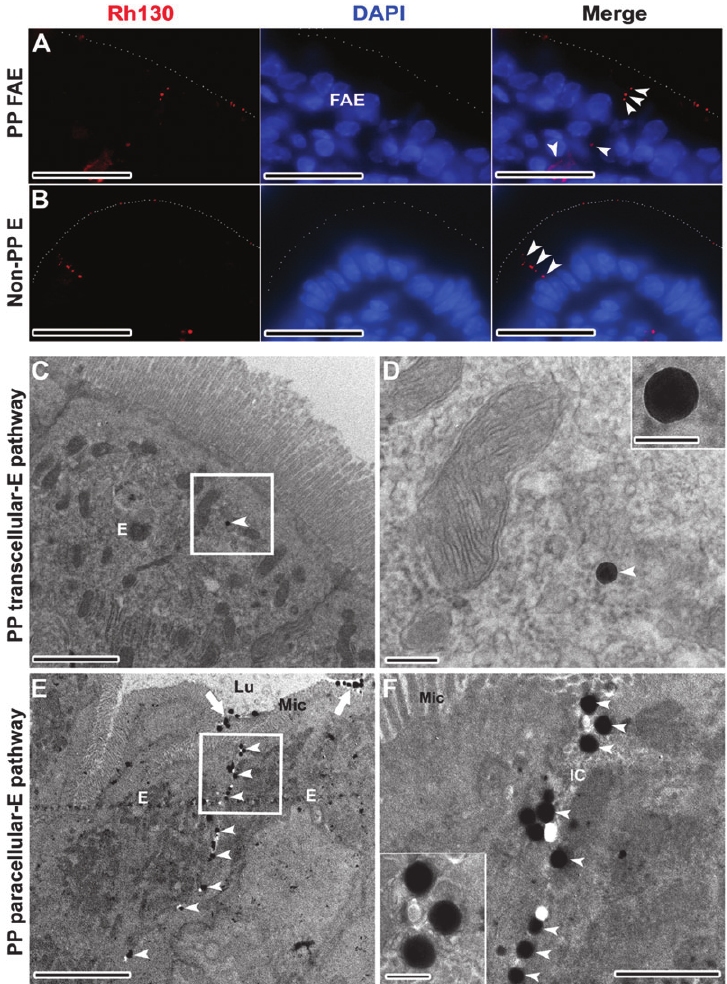
Figure 9 Fluorescence microscopic and electron microscopic images of mouse Peyer ’ s patches follicle-associated epithelium (PP FAE) and non-Peyer ’ s patches epithelium (non-PPE) 4 h after oral administration of fl uorescent thiol-organosilica particles. (A) Linear fl orescence from particles (arrowheads) adjusting between two Peyer ’ s patches enterocytes. (B) Linear fl orescence from particles (arrowheads) adjusting between two non-Peyer ’ s patches enterocytes. (C, D) Three Peyer ’ s patches enterocytes (E) and fl uorescent thiol-organosilica particles (arrow- heads) within the cytoplasm [white box (C) and enlarged (D)]. (E, F) Particles in the lumen (Lu), between microvilli (Mic) (bold arrows), and adjusting in one line in the intercellular space (IC) between two enterocytes (E) [white box (E) and enlarged (F)]. Scale bar = 25 μ m (A, B); 2 μ